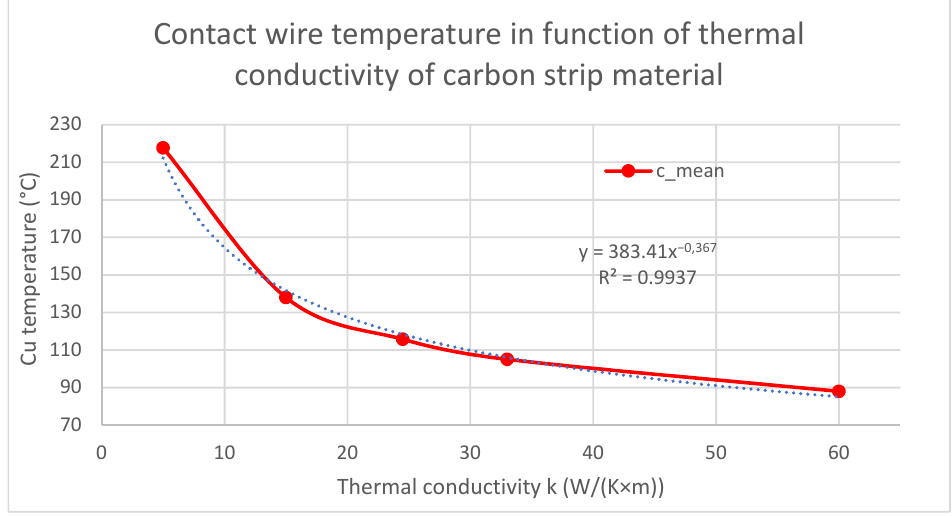
Figure 14. Contact wire temperature - Cu temperature (°C) as a function of thermal conductivity of carbon strip material.